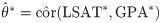
Comparison between the data re-sampling approaches and the vectorized multinomial sampling bootstrap, in the American law school data.Panel a compares the approach’s time expenditures. Panels b, c and d compare, respectively, the computation time ratio of the “for loop”, “R/bootstrap” and “R/boot” approaches against the vectorized bootstrap. The bottom panels present the θ^*=co^r(LSAT*,GPA*) distributions generated with B = 1,000,000.